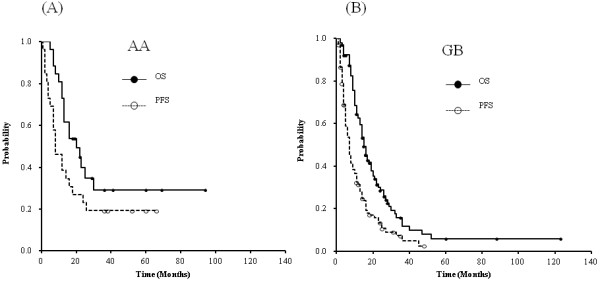
Kaplan-Meier curves of overall survival and progression-free survival for
each histological grade. Kaplan-Meier curves of progression-free
survival (PFS) and overall survival (OS) according to histology grade:
(A) anaplastic astrocytoma (n = 26), (B)
glioblastoma (n = 105).